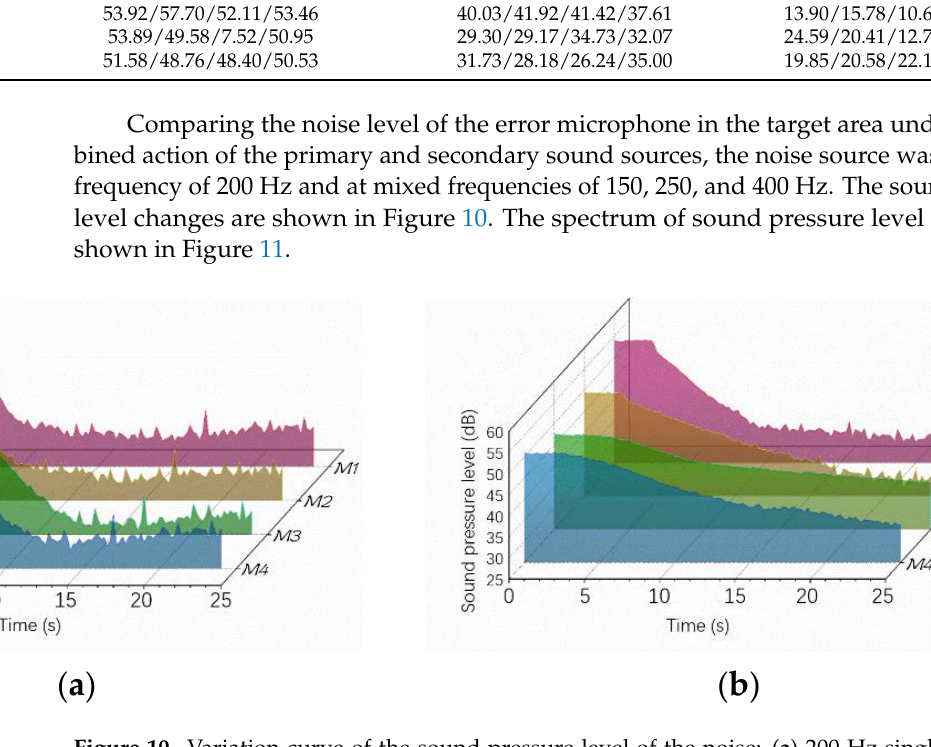
Table 3. 4 ‐ channel fractional ‐ order ANC noise cancellation statistics.